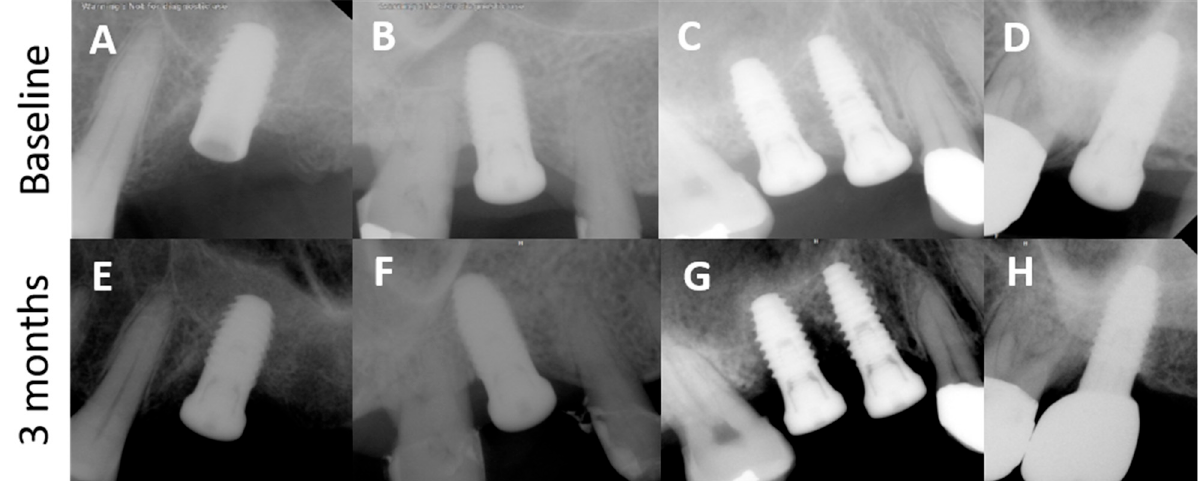
Figure 4. Periapical radiographs taken at baseline and 3 months. ( A , B , C , and D ) represent Cases 1, 2, 3, and 4, respectively, at baseline. ( E , F , G , and H ) represent cases 1, 2, 3, and 4, respectively, at 3 months postoperative.